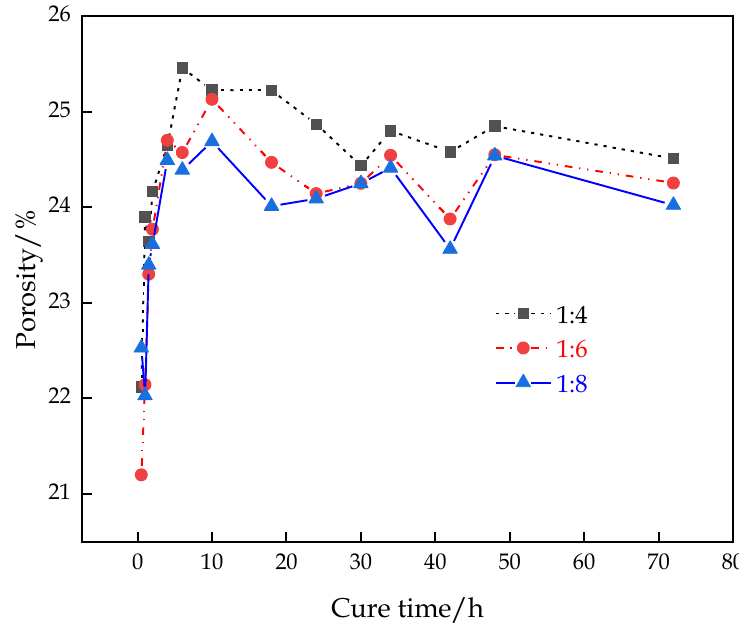
Figure 5. Pore size distribution of CFTFS.